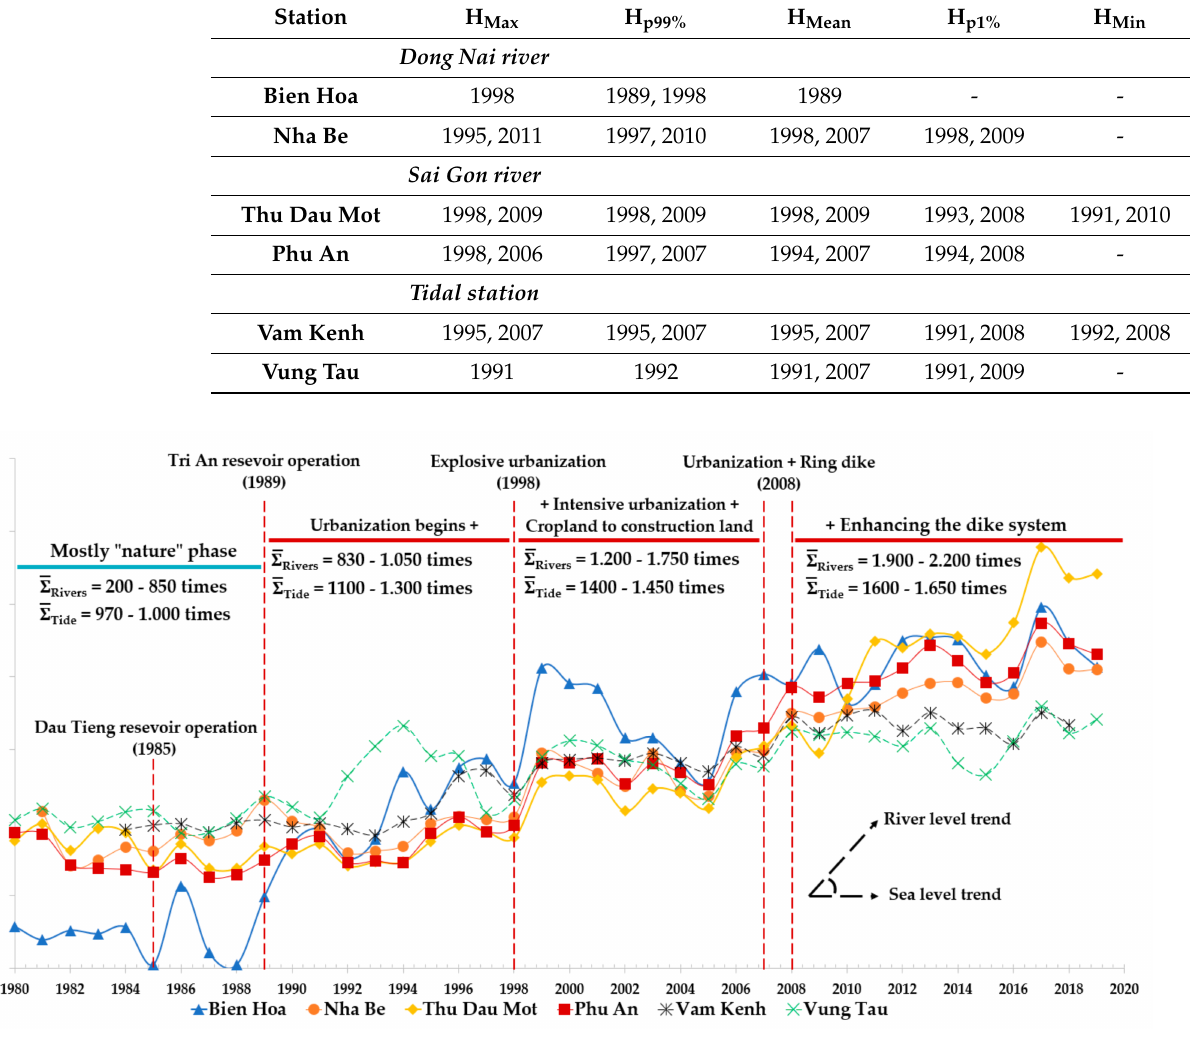
Figure 10. Overview of the water level changes in 1980–2019 corresponding to socio-economic development